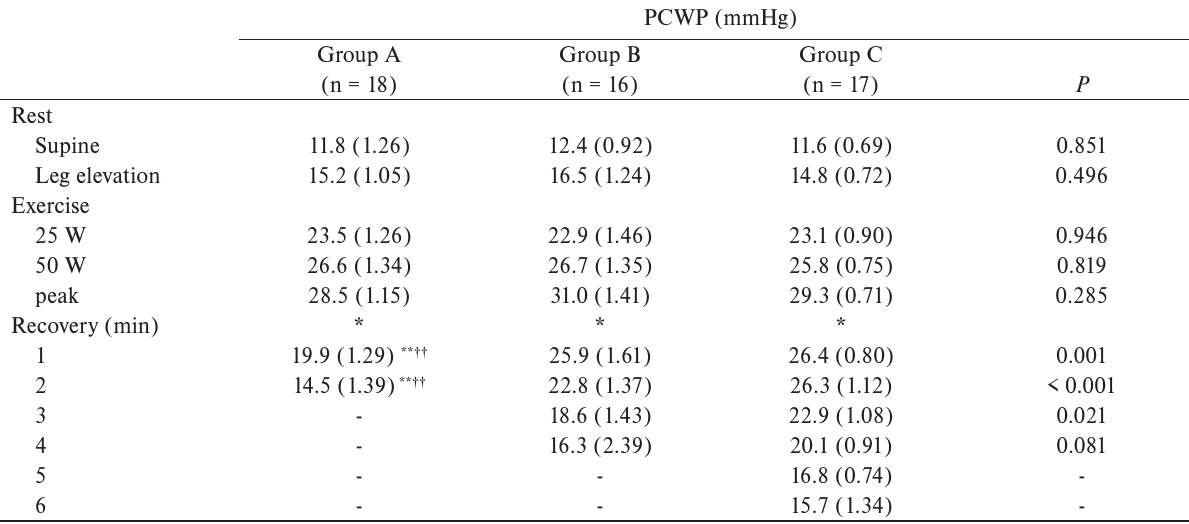
PCWP, pulmonary capillary wedge